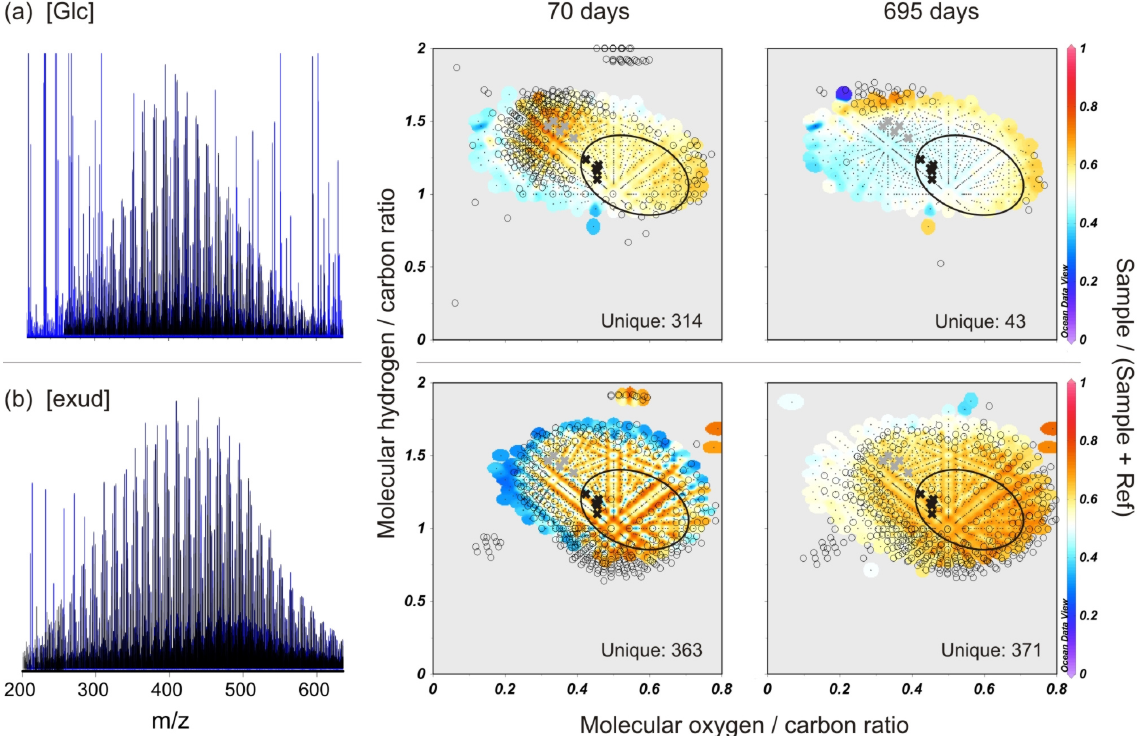
Figure 6. FT-ICR mass spectra of the solid-phase extracts of microbially degraded (a) glucose [Glc] and (b) algal-exudate [exud] after 70 and 695 days of incubation. Left panel: measured spectra (in blue) and reconstructed spectra based on all identified molecular formulas containing C, H and O (in black). Right panel: van Krevelen plots represent all CHO molecular formulas. Formulas which occurred uniquely in the samples and not in the controls (average of sc [none], sc [Glc], c [none] for [Glc] and sc [exud] for [exud]) are marked with a black circle. All other formulas are represented by the color which reflects the ratio of the peak magnitude in the sample versus the respective magnitude in the controls (Sample/(Sample + Ref)). The black circle represents the area in which molecular formulas with the highest residence times in the ocean would be displayed (according to Lechtenfeld et al., 2014; island of stability). The crosses represent those 10 peaks which are used to calculate the degradation state of marine DOM (Flerus et al., 2012; I deg ) : grey crosses represent molecular formulas which are labile; black crosses represent refractory molecular